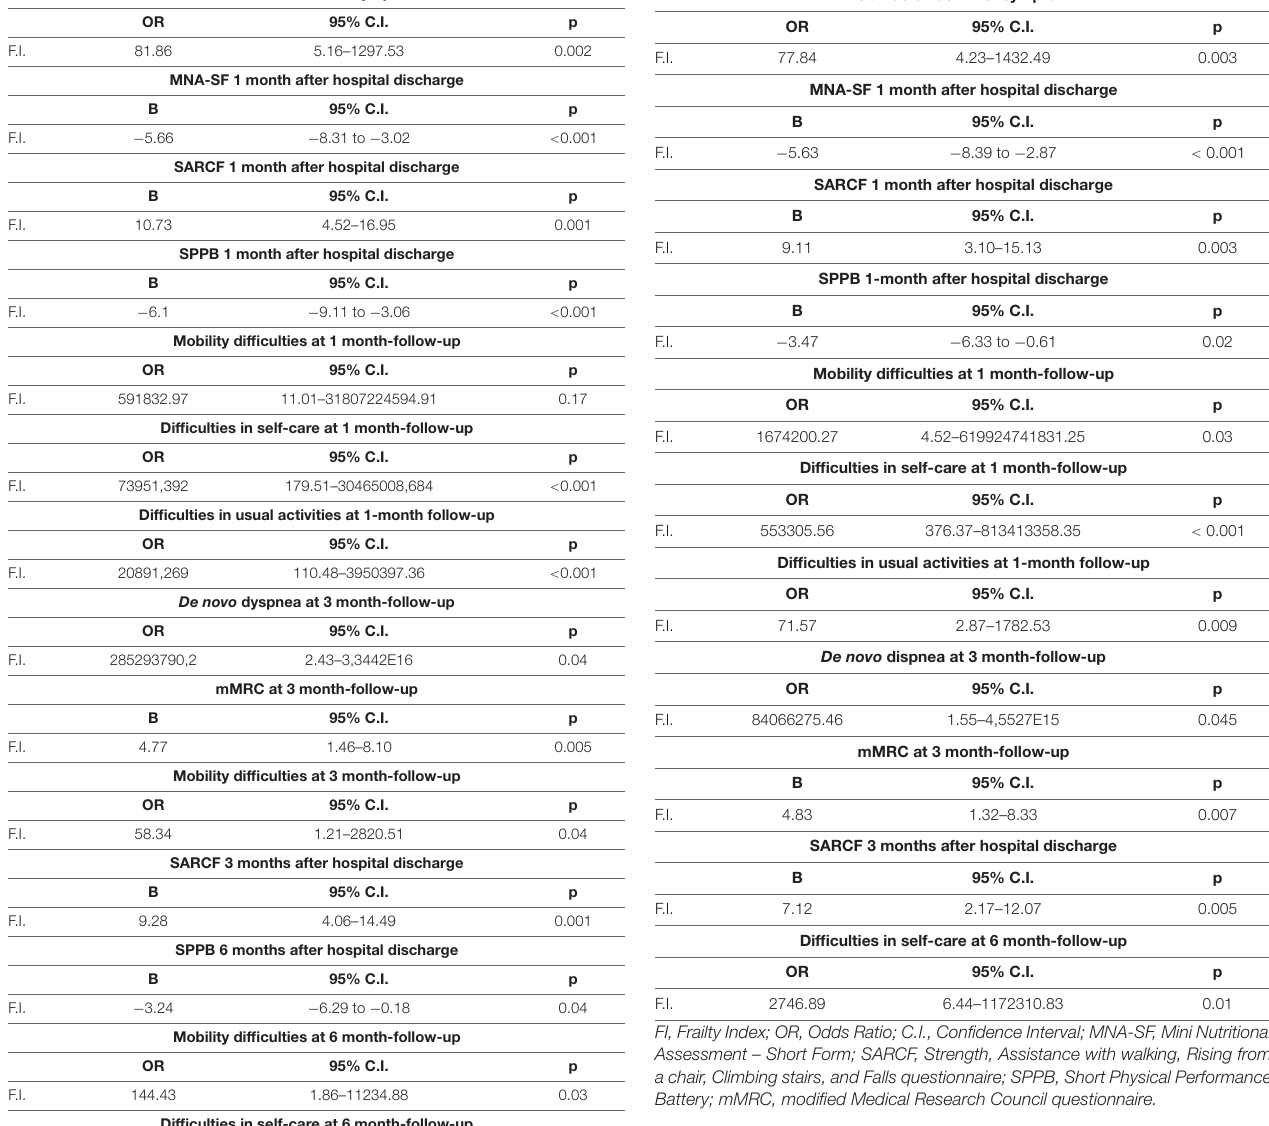
TABLE 6 | Results of the age- and sex-adjusted regression models exploring the TABLE 5 | Results of the univariate regression models exploring the association between frailty and the PASC manifestations during the follow-up. association between frailty and the PASC manifestations during the follow-up. Confusion as initial symptom Confusion as initial